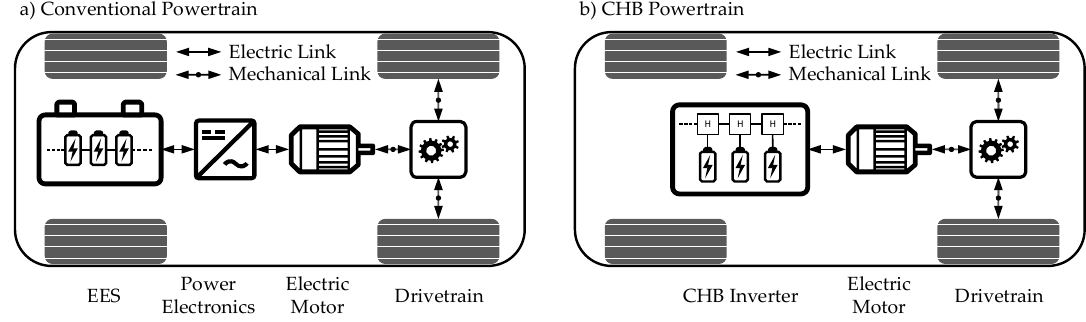
Figure 2. Illustration of the overall electrical architecture of a ( a ) conventional powertrain and ( b ) cascaded H-bridge powertrain.